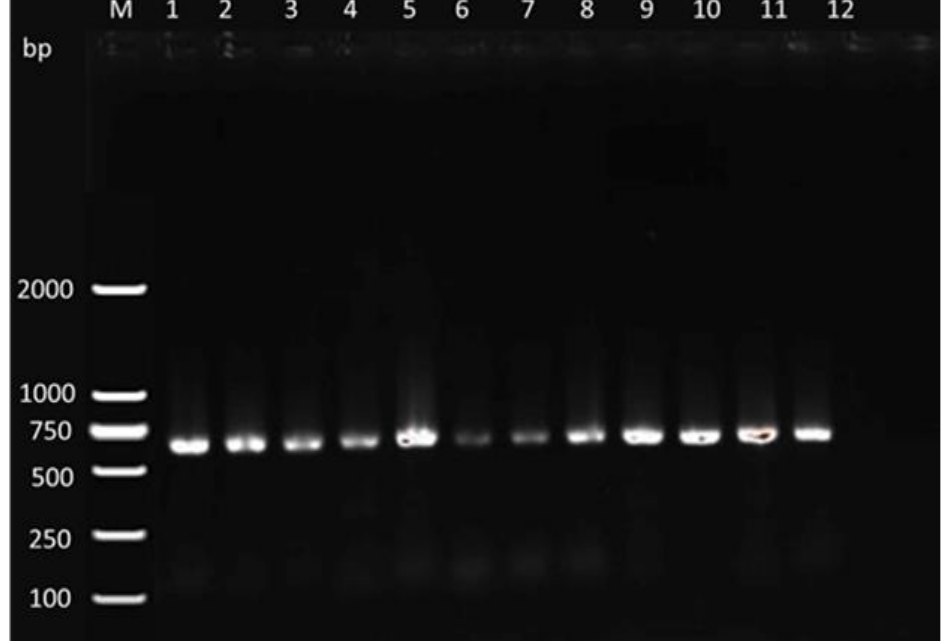
Figure 2: Test of PCR result on Bactrocera and Zeugodacus by gel electrophoresis. Line 1-4, Bactrocera spp.; line 5-12, Zeugodacus and line M: D2000 Marker.